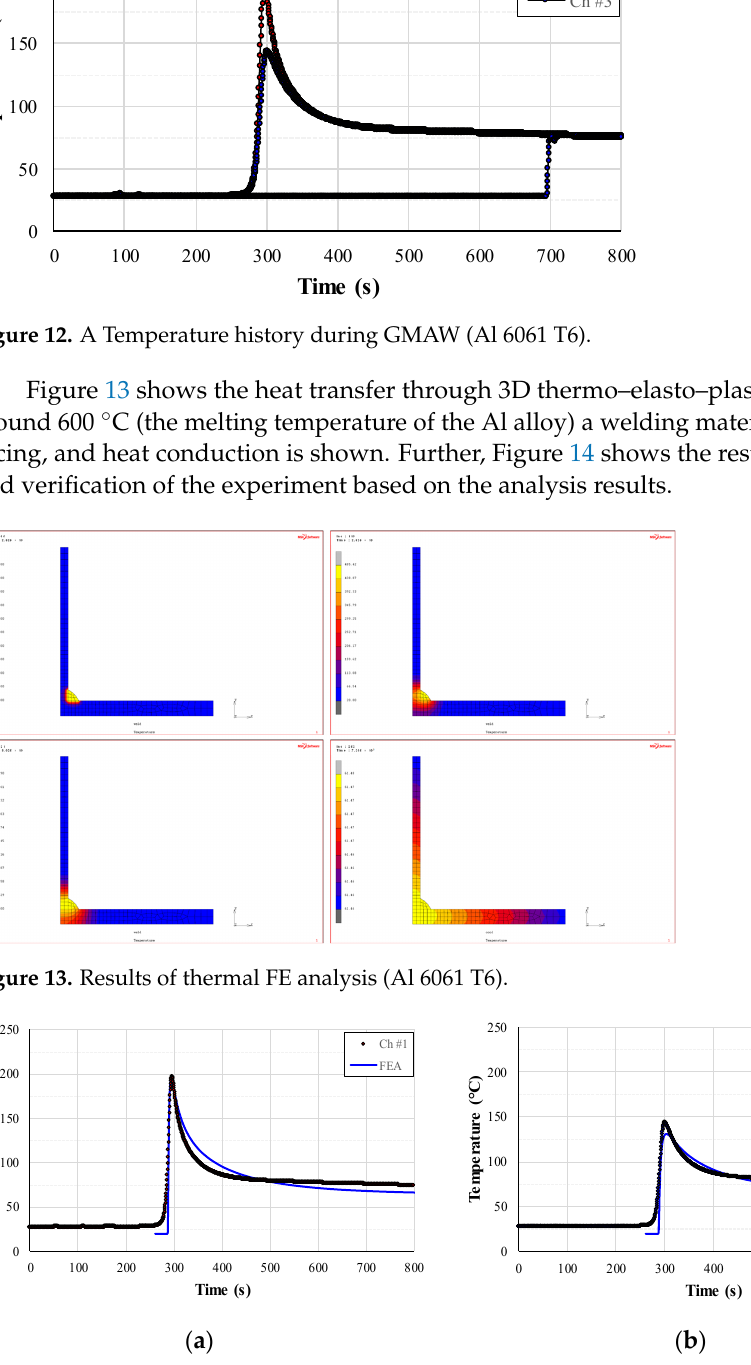
Figure 13. Results of thermal FE analysis (Al 6061 T6). Figure 14. Comparison of temperature history of Ch#1 and #2 of Al 6061 T6 based on experiment versus FE analysis: ( a ) Ch#1 position; ( b ) Ch#2 position. In addition to verifying the accuracy of the heat source model through the tempera- ture history, comparison and verification through the HAZ area during Al alloy welding were also performed. According to the related literature [31], the HAZ temperature range of the Al alloy is known to be about 460 °C. Figure 15 shows the comparison between the thermal analysis model and the actual HAZ through the macro section. As can be seen, the validity of the proposed GMAW of Al alloy welding-heat-source model was confirmed through HAZ region comparison.